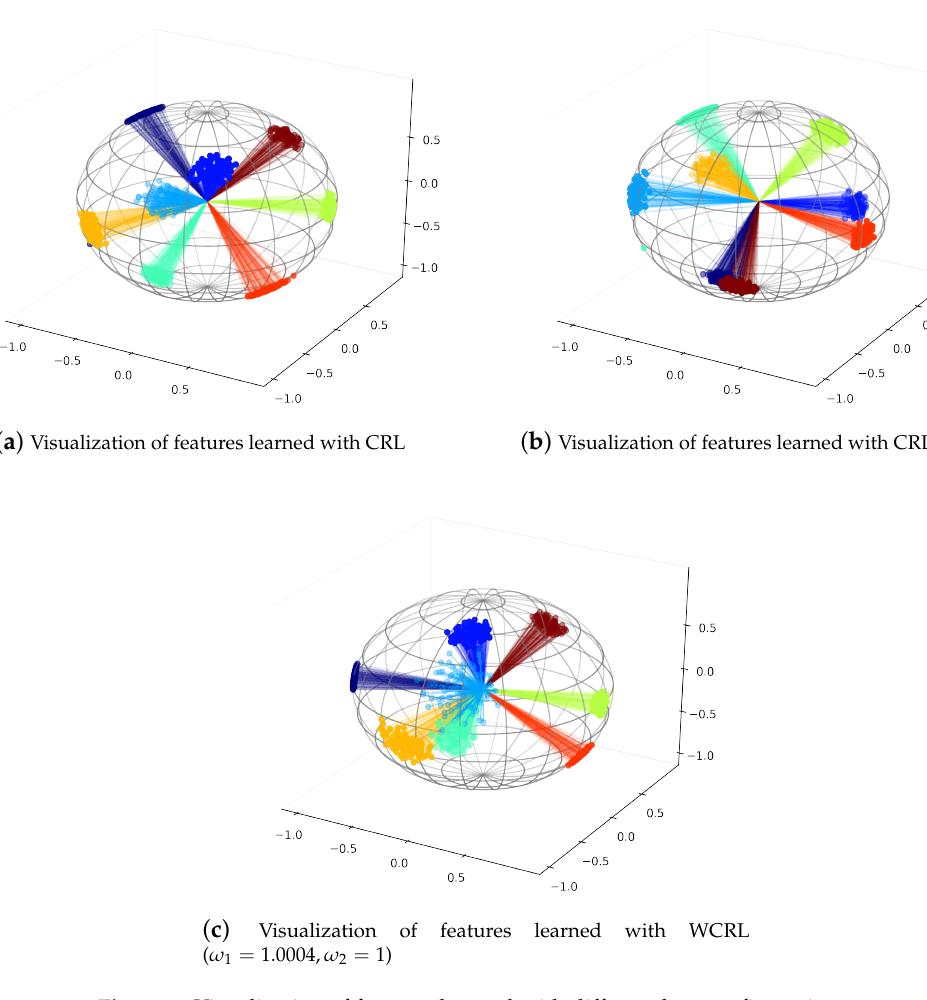
Figure 9. Visualization of features learned with different loss